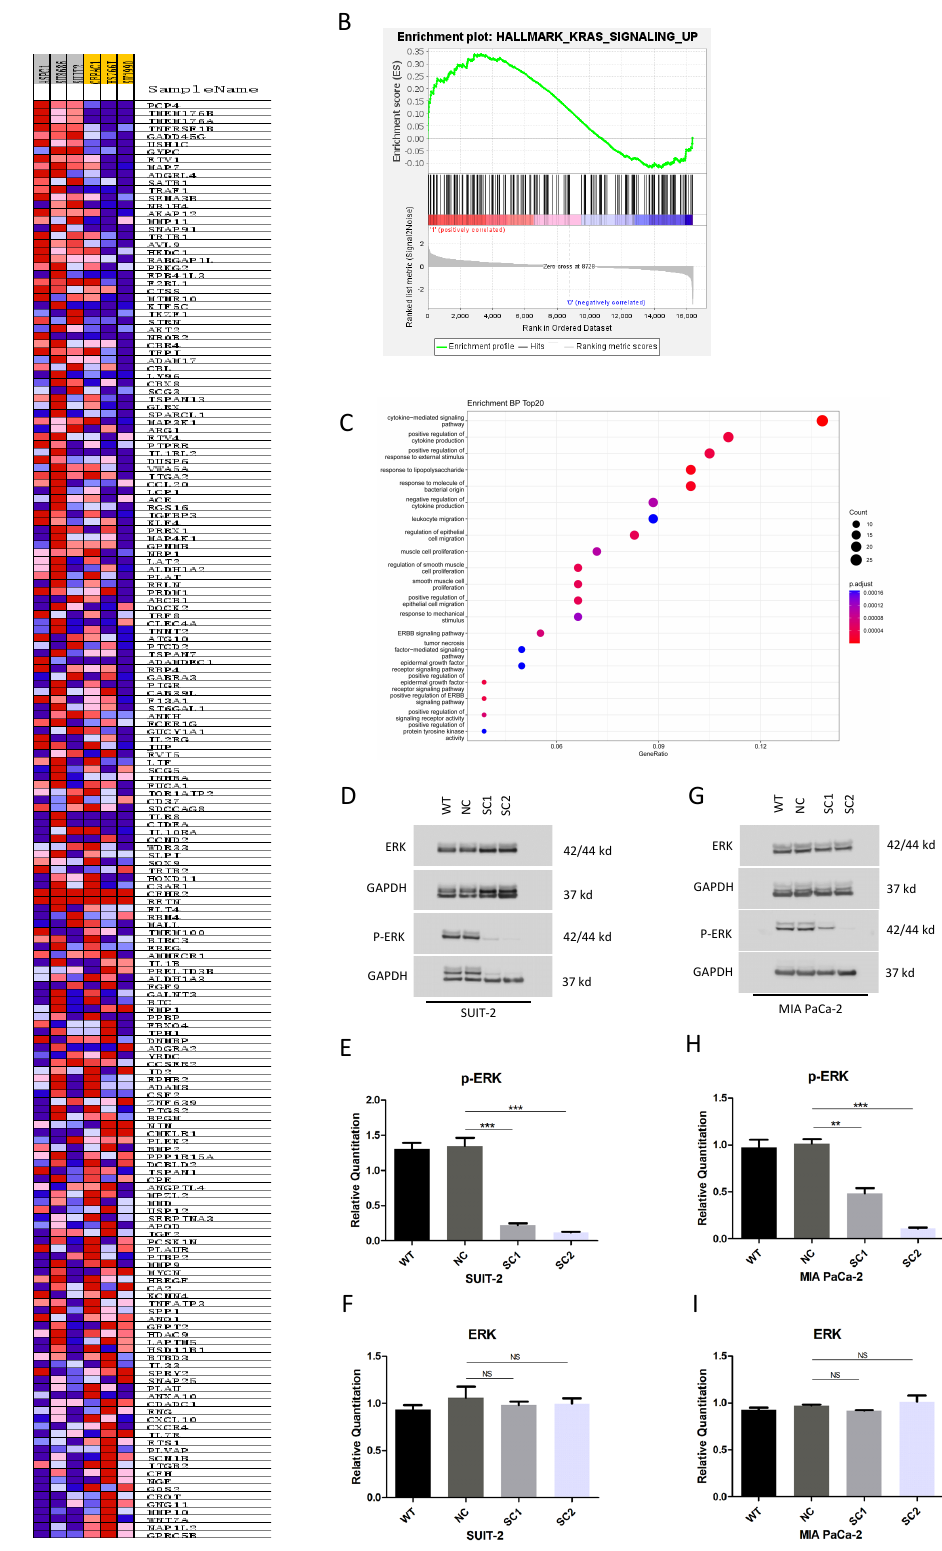
Figure 8. Knockout of PCSK6 suppressed the Raf-MEK1/2-ERK1/2 axis. ( A ) Heatmap of the ex- pressions of genes involved in the Kras signaling pathway between the PCSK6-high group and the PCSK6-low group. ( B ) Enrichment plot of the Kras signaling pathway. ( C ) Top 20 enrichment cate- gories of BP. ( D – F ) Activities of ERK and p-ERK in SUIT-SCs and controls. ( E , F ): relative